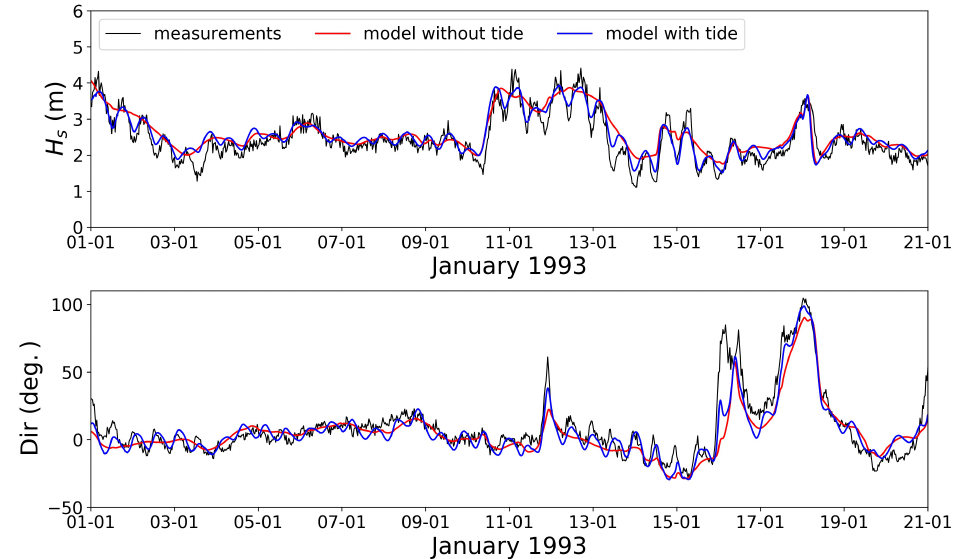
Figure 6. Measured (black line) and computed times series of the significant wave height H s and the mean wave direction (anticlockwise convention from the East) in January 2013 off western Brittany (France) (mean water depth of 60 m) without (red line) and with (blue line) the effects of the tide—adapted from